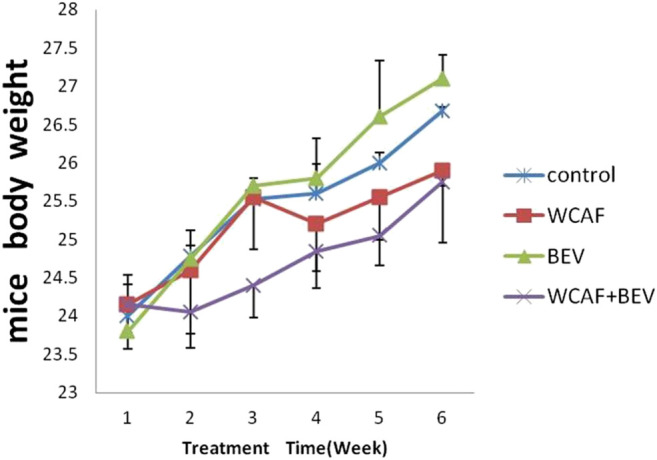
mice body weight curve.